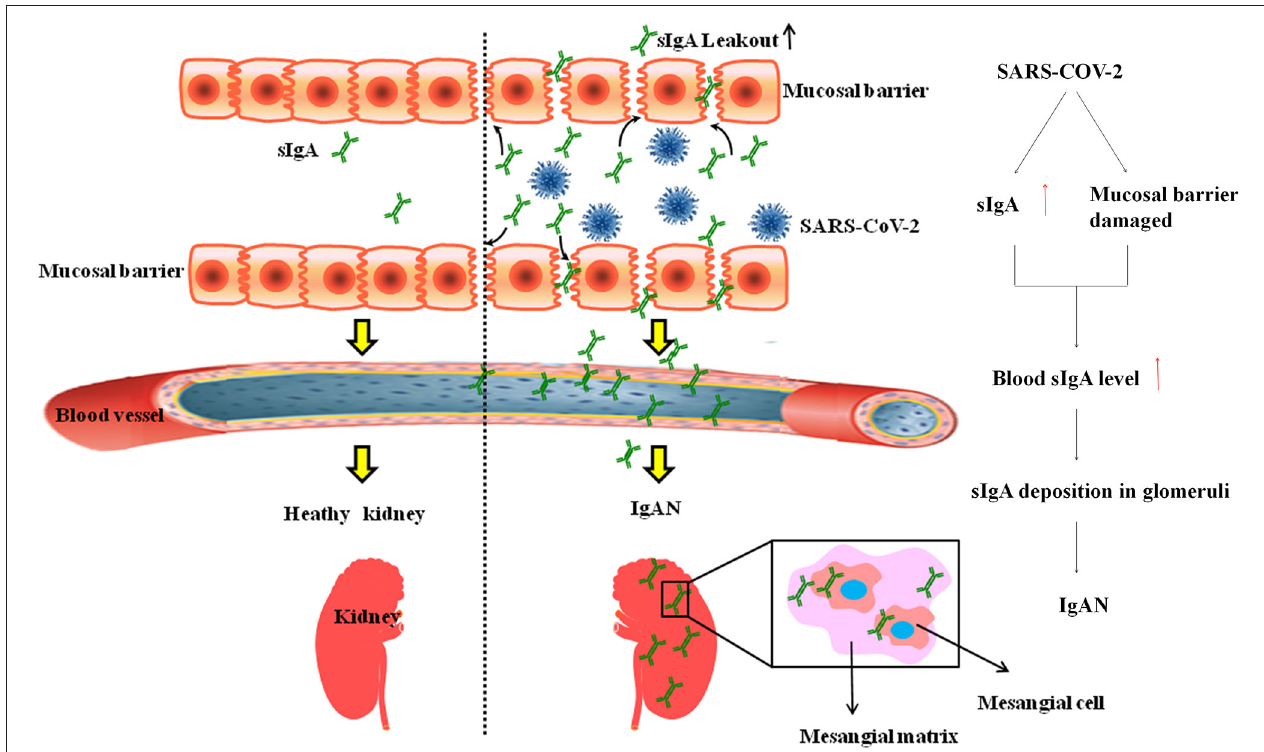
FIGURE 1 | SARS-COV-2 Lead to IgAN. SARS-CoV-2 invades the mucosa of the respiratory tract and digestive tract, increased gut permeability leads to leakage of sIgA and promotes the deposition of IgA-C3 complex in the mesangial area of the glomeruli to cause